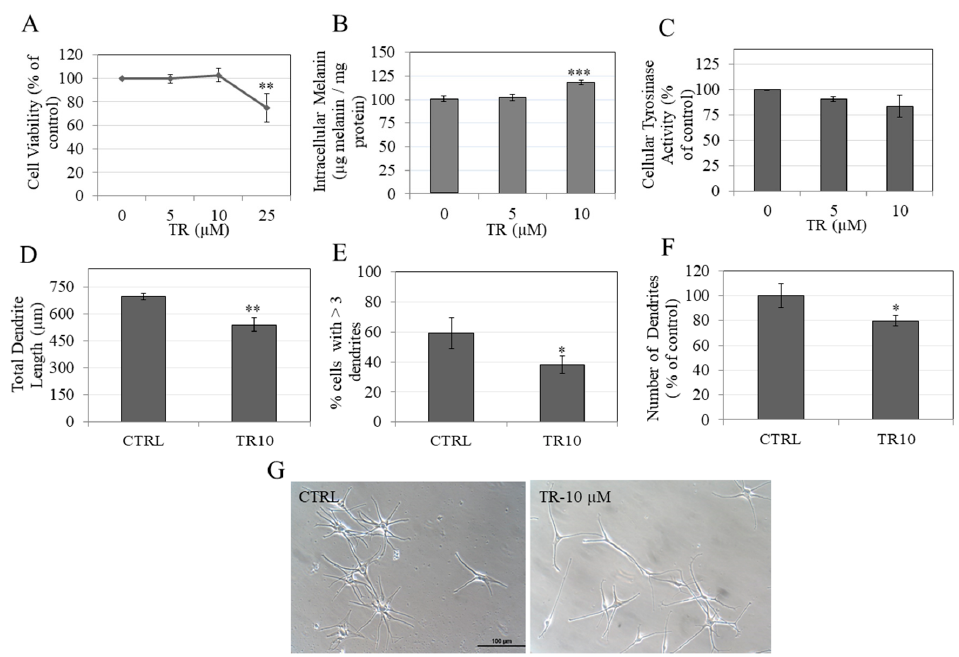
Figure 6. ( A ) Human Epidermal Melanocyte (HEM) cell viability in the presence of different concentrations of TR; ** p < 0.01; One-way ANOVA with Dunnett’s test; Data is mean ± SD of three independent experiments; ( B ) Intracellular melanin quantitation in HEM-DP cells treated with TR for 3 d; *** p < 0.001; One-way ANOVA with Dunnett’s test; Data is mean ± SD of a representative independent experiment in triplicates; ( C ) Cellular tyrosinase activity in HEM-DP cells; Data is mean ± SD of at least two independent experiments; Quantification of dendricity measured by ( D ) Total dendrite length; ( E ) % cells > 3 dendrites and; ( F ) number of dendrites as % of control in HEM-DP cells treated with TR for 3 d; Data are mean ± SD of triplicate determinations for ( D )–( F ); a total of up to 50 cells were counted from each group; * p < 0.05; ** p < 0.001; students unpaired t-test; ( G ) Representative phase-contrast micrograph showing HEM-DP cells in vehicle treated (DMSO) and TR - 10 µM treated group.